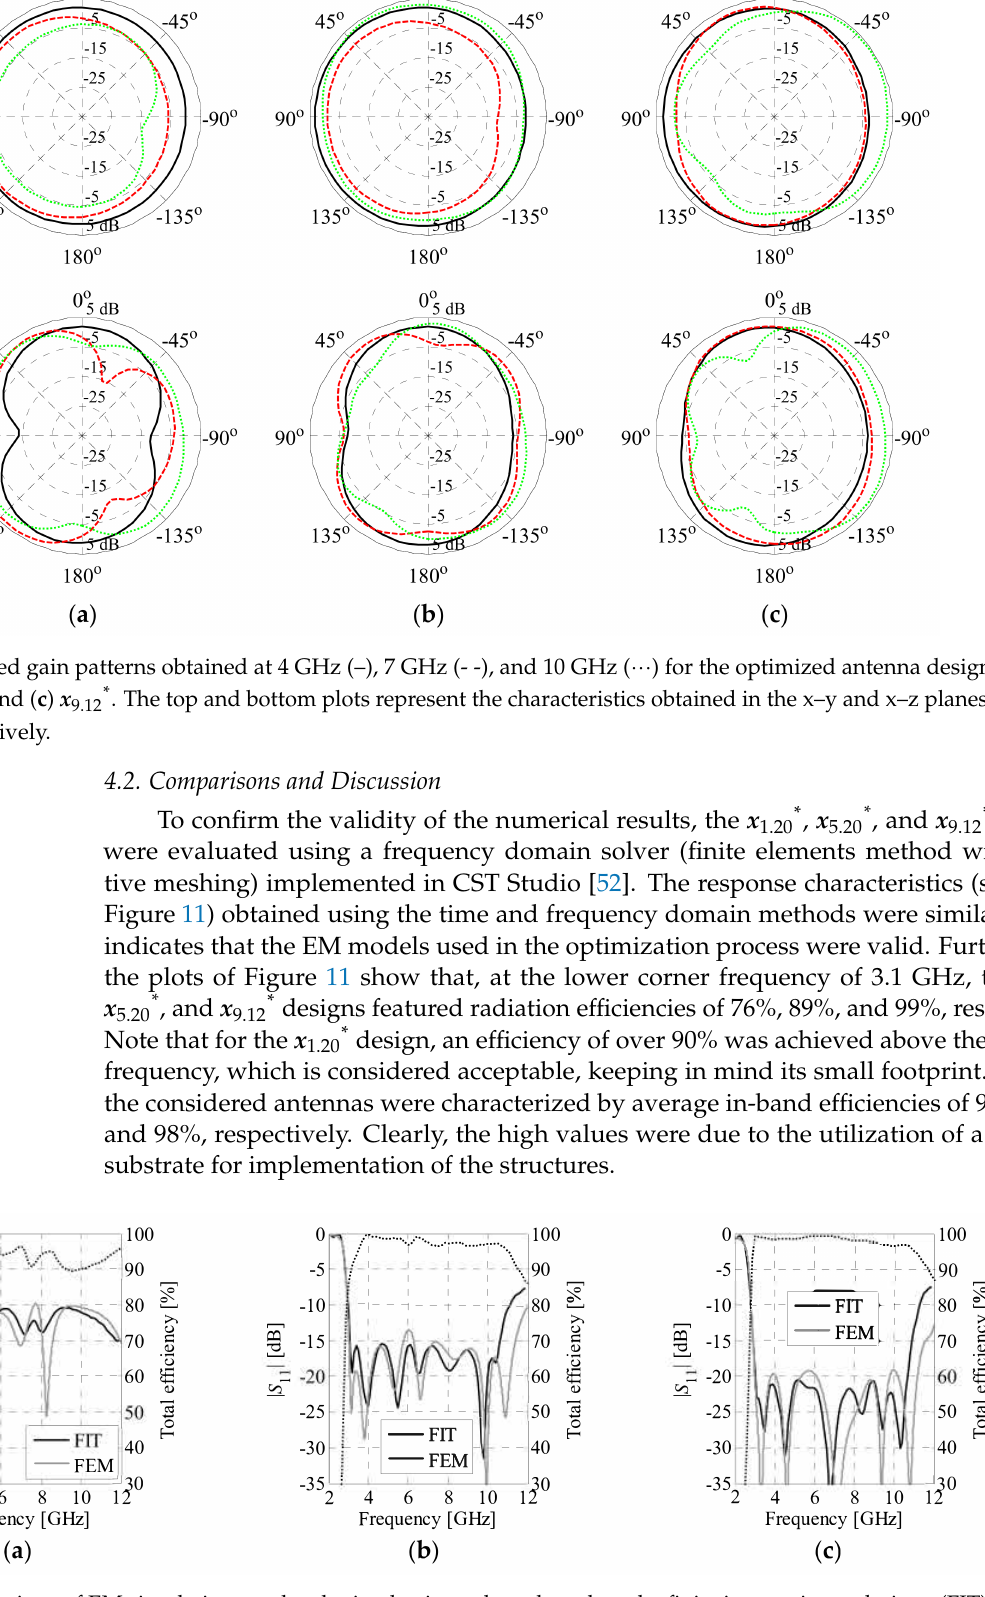
Figure 11. Comparison of EM simulation results obtained using solvers based on the finite integration technique (FIT) and finite elements method (FEM) for the designs ( a ) x 1.20 * , ( b ) x 5.20 * , and ( c ) x 9.12 * . The dotted lines represent the total efficiency, evaluated using the FIT